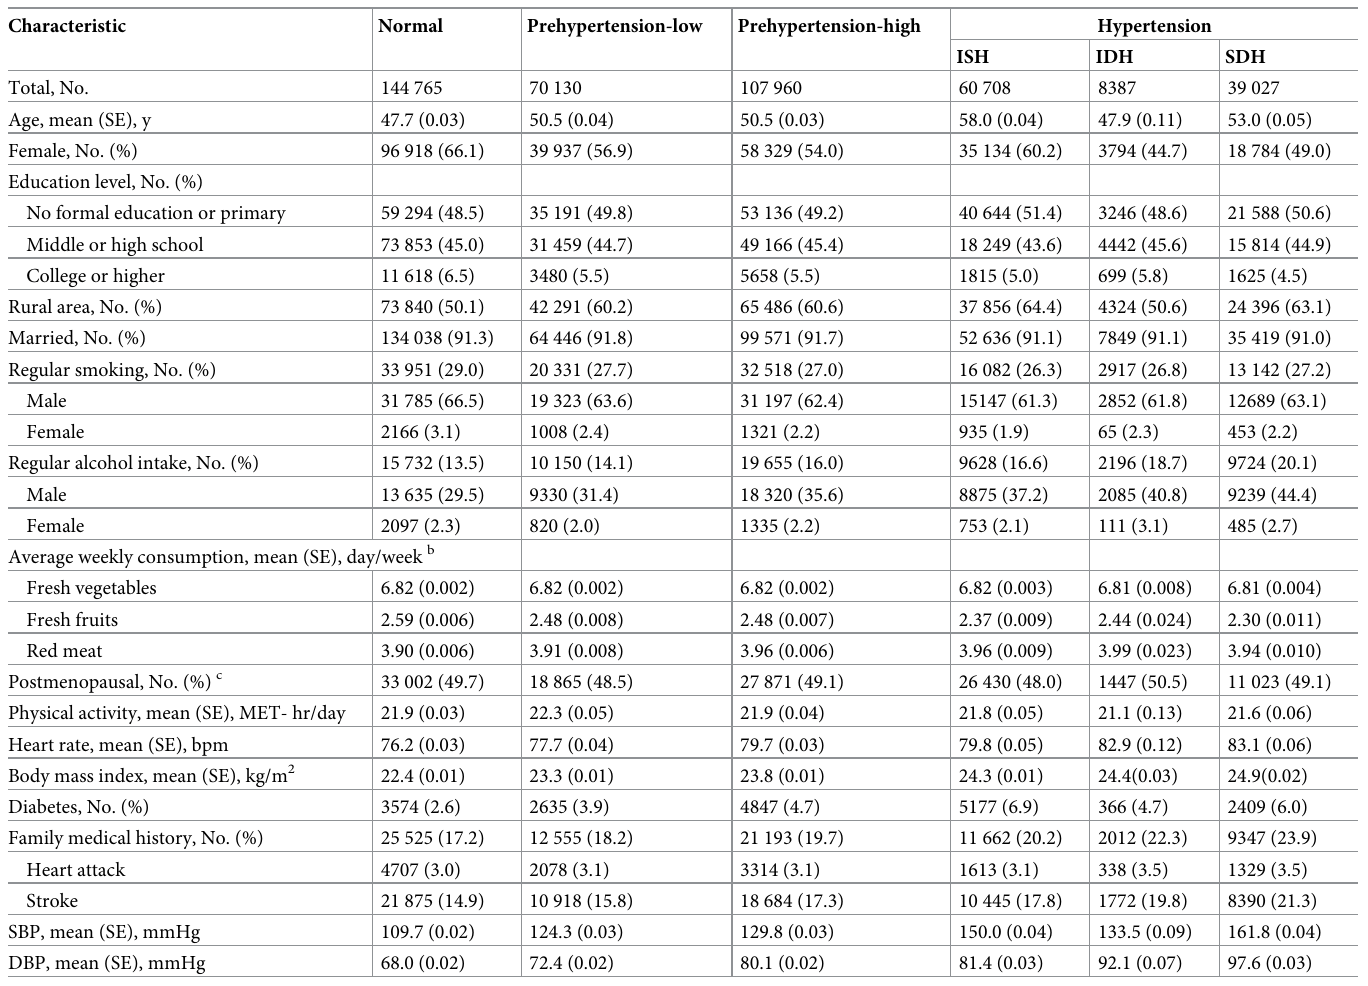
Table 1. Baseline characteristics of the study population by baseline BP categories a